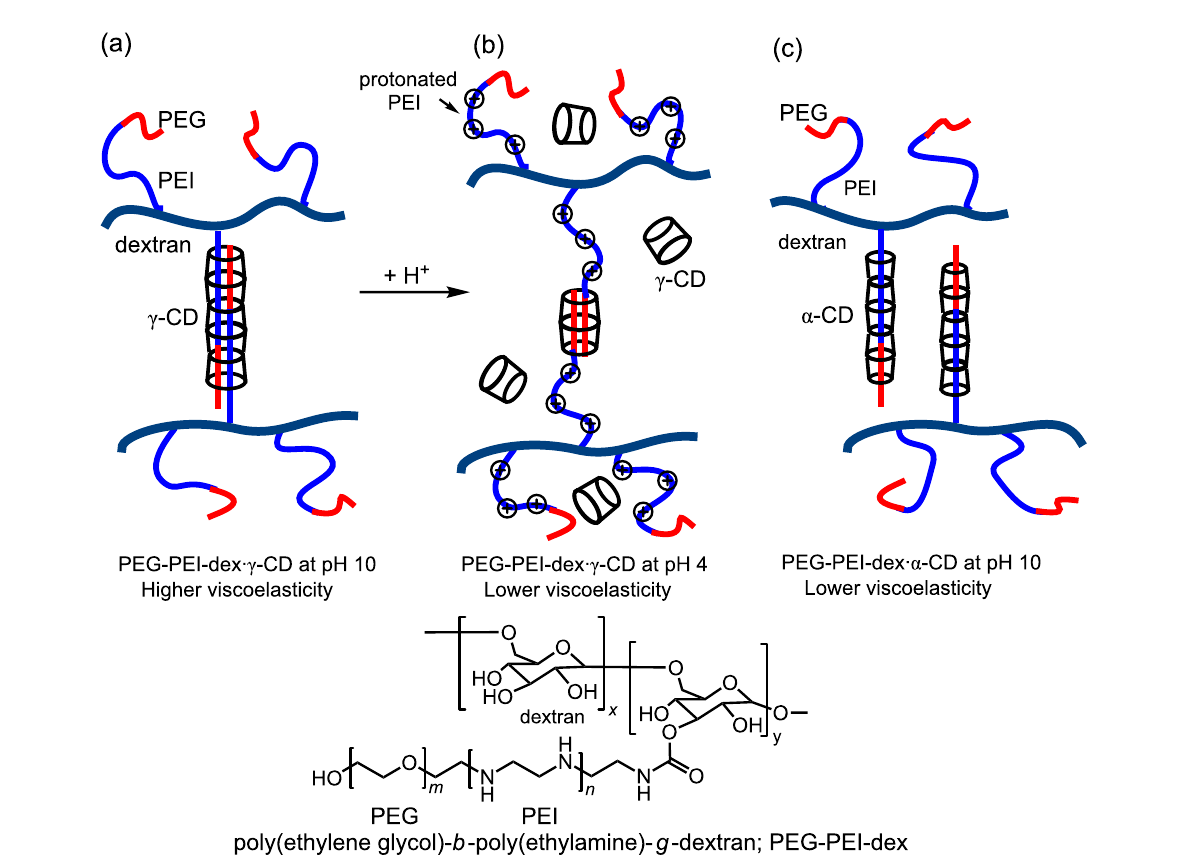
Figure 16: The structures proposed for the poly(ethylene glycol)- b -poly(ethylamine)- g -dextran· γ -CD, PEG-PEI-dex· γ -CD, supramolecular hydrogel at (a) pH 10 and (b) its much lower viscoelastic protonated form at pH 4. The proposed structure of the PEG-PEI-dex· α -CD at pH 10 is shown in (c)